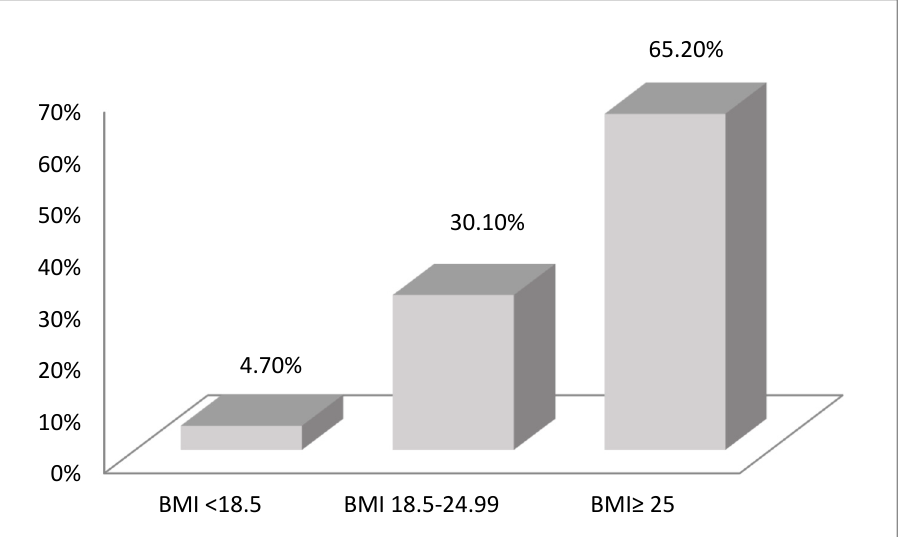
Figure 1. The percentage of BMI categories in KTRs. Based on 7-point SGA, 39% of KTRs were moderately/slightly malnourished (Figure 2). 36.2% of moderately/slightly malnourished KTRs (with SGA ≤ 5) were overweight or obese.